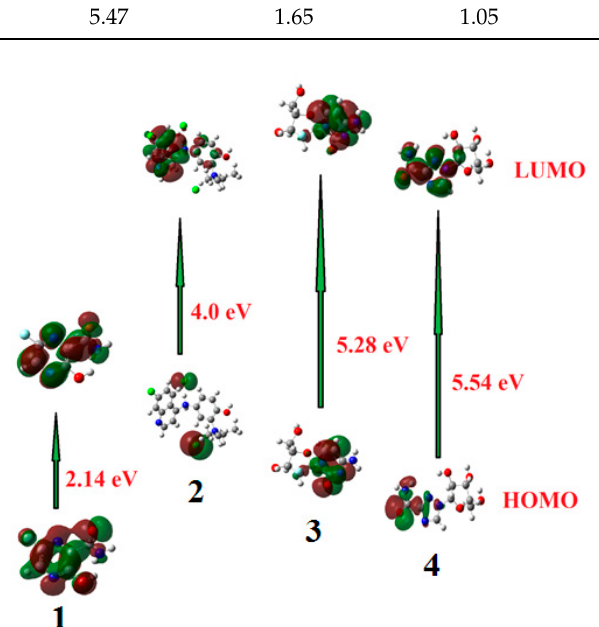
Figure 2. The calculated ground state isodensity surface plots for Frontier molecular orbitals (FMOs) for investigated drugs 1 ‒ 4 . for investigated drugs 1–4